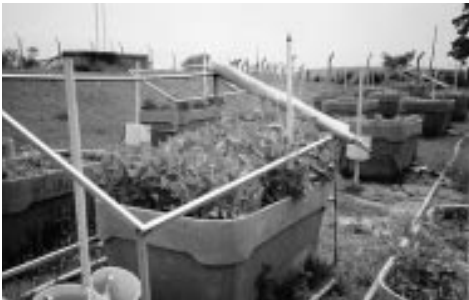
Figura 1. Vista geral do experimento e estruturas de manejo e monitoramento do